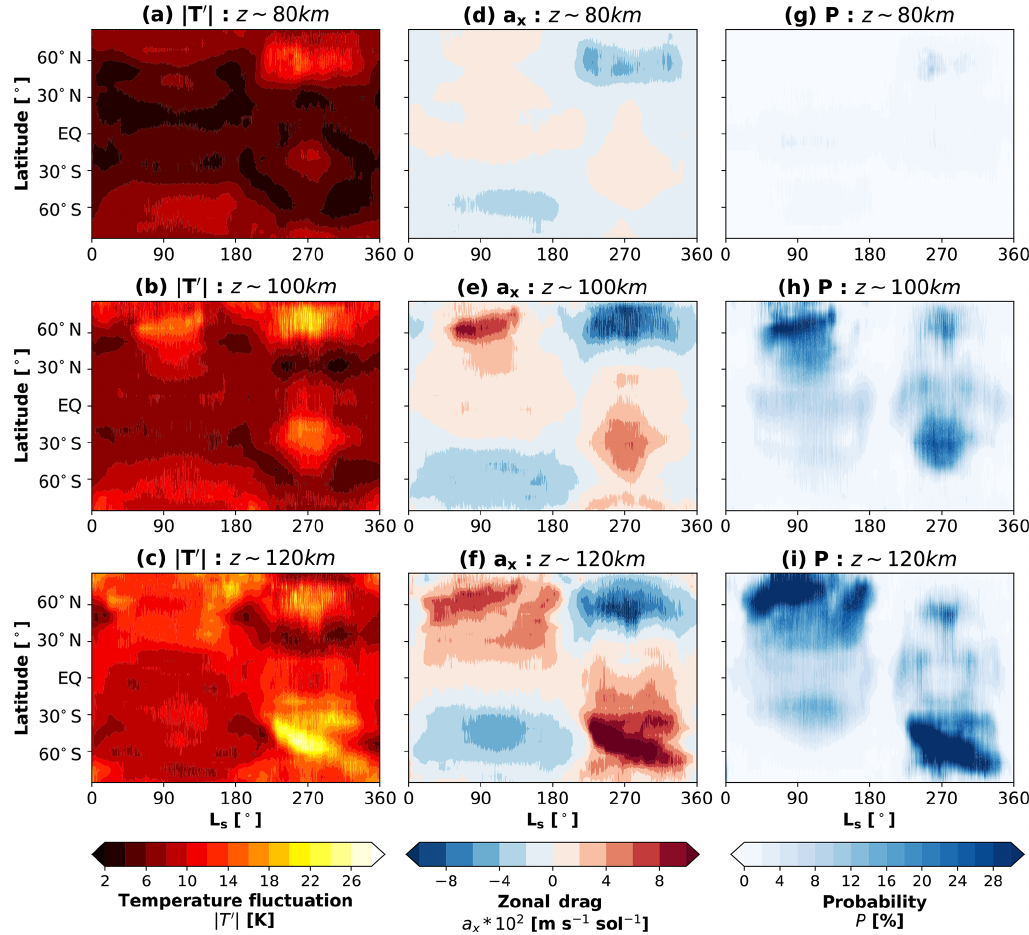
Figure 5. Seasonal variations of cloud formation probability, GW drag, and GW-induced temperature fluctuations: (a) GW-induced temper- ature fluctuations ( | T (cid:48) | ) at 80km, (b) | T (cid:48) | at 100km, and (c) | T (cid:48) | at 120km, (d) GW zonal drag ( a x ) at 80km, (e) a x at 100km, (f) a x at 120km, (g) cloud formation probability ( P ) at 80km, (h) P at 100km, and (i) P at 120km. Probabilities are in percentage; zonal drag is in ms − 1 sol − 1 , and temperature fluctuations are in K. In the drag plots ( d–f ), red/blue represents eastward/westward GW drag. Presented model data are in terms of daily and zonal averages. Note that the zonal drag is plotted in 200ms − 1 sol − 1 intervals. L s = 0 ◦ marks the vernal equinox in the Northern